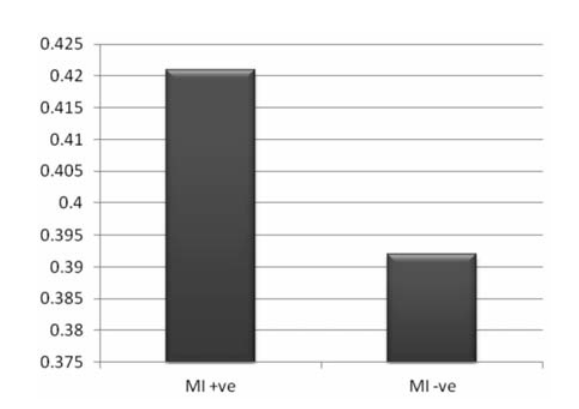
Figure 4. Distribution of H. pylori specific heat shock protein- 60antibodies in patients with and without myocardial